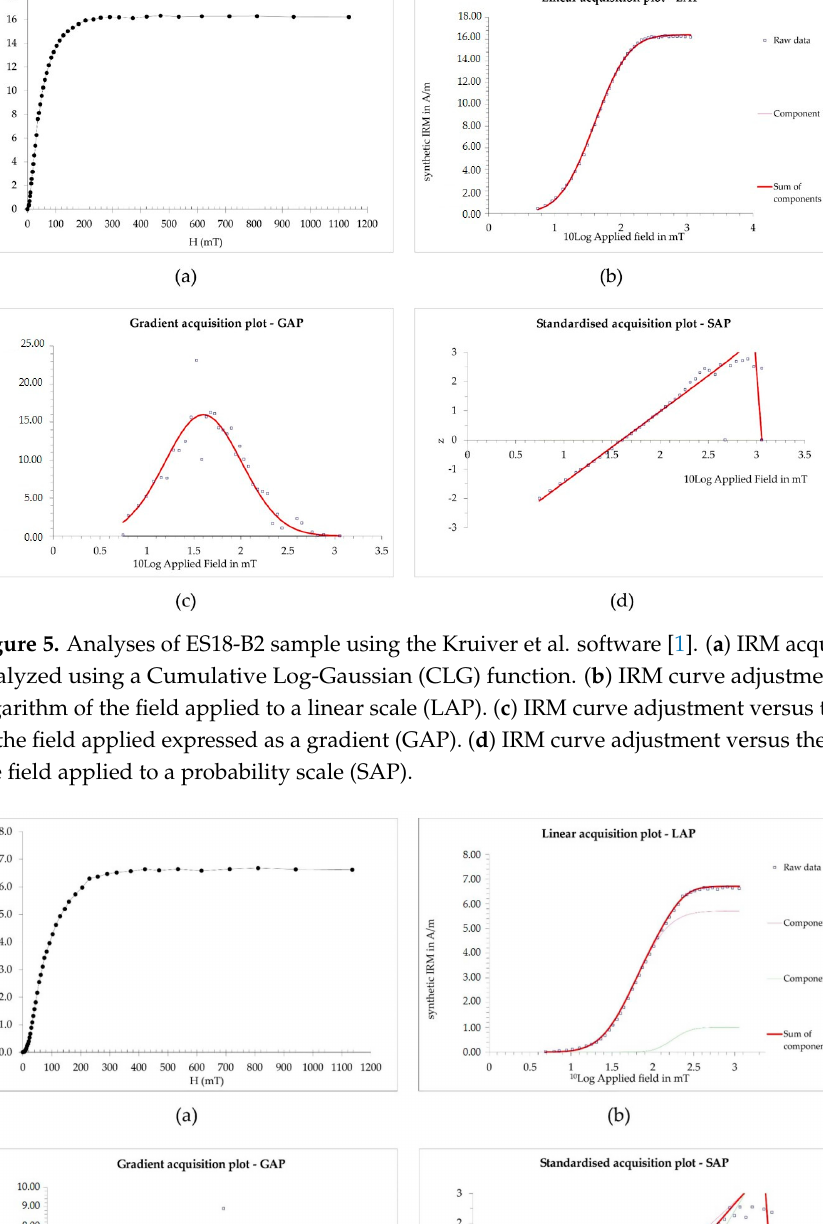
Figure 4. Analyses of ES18-A1 sample using the Kruiver et al. software [1]. ( a ) IRM acquisition curve analyzed using a Cumulative Log-Gaussian (CLG) function. ( b ) IRM curve adjustment versus the logarithm of the field applied to a linear scale (LAP). ( c ) IRM curve adjustment versus the logarithm of the field applied expressed as a gradient (GAP). ( d ) IRM curve adjustment versus the logarithm of the field applied to a probability scale (SAP).